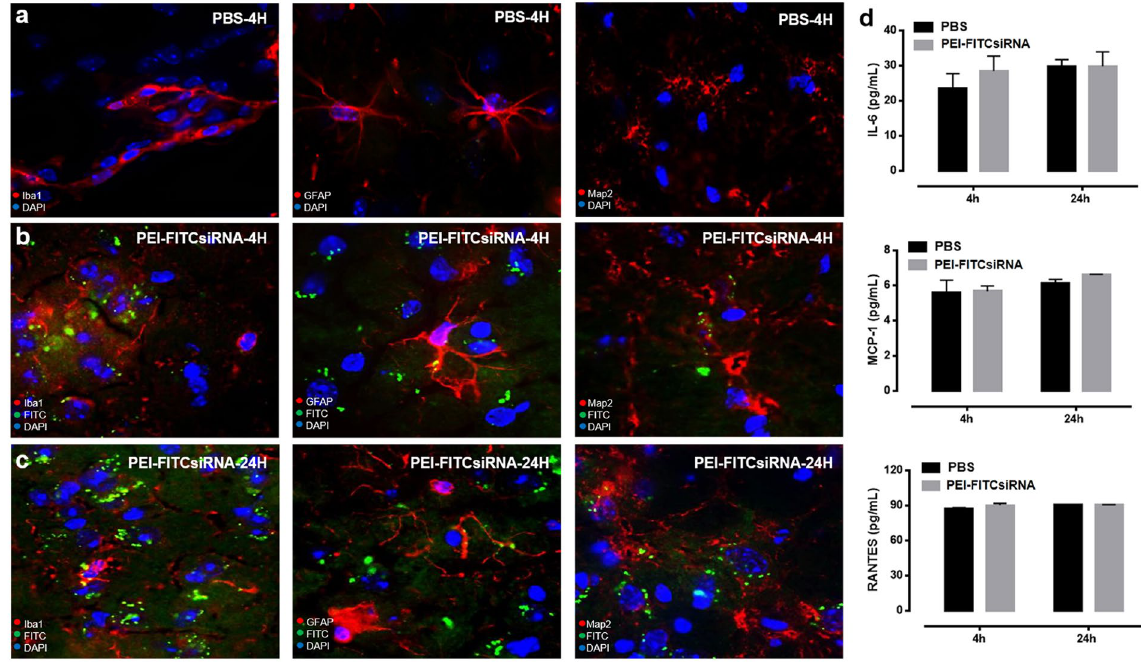
Figure 2. Cell-type distribution of PEI-FITCsiRNA in mouse brain following intranasal administration. Representative images of brain sections immunolabeled with antibodies to the microglial marker, Iba1 (left panel), astrocyte marker, GFAP (middle panel), and neuronal marker, Map2 (right panel), in red for ( A ) PBS treatment, and PEI-FITCsiRNA (indicated by green fluorescence) administration for ( B ) 4 hours and ( C ) 24 hours. DAPI ( blue) staining indicates cell nuclei at 63X magnification. ( D ) The other half of brain tissues was used to detect the indicated cytokines and chemokines by ELISA after 4 and 24 hours. Values were determined from standard curves and are presented as the mean ± the standard error of the mean (S.E.M.) of three independent